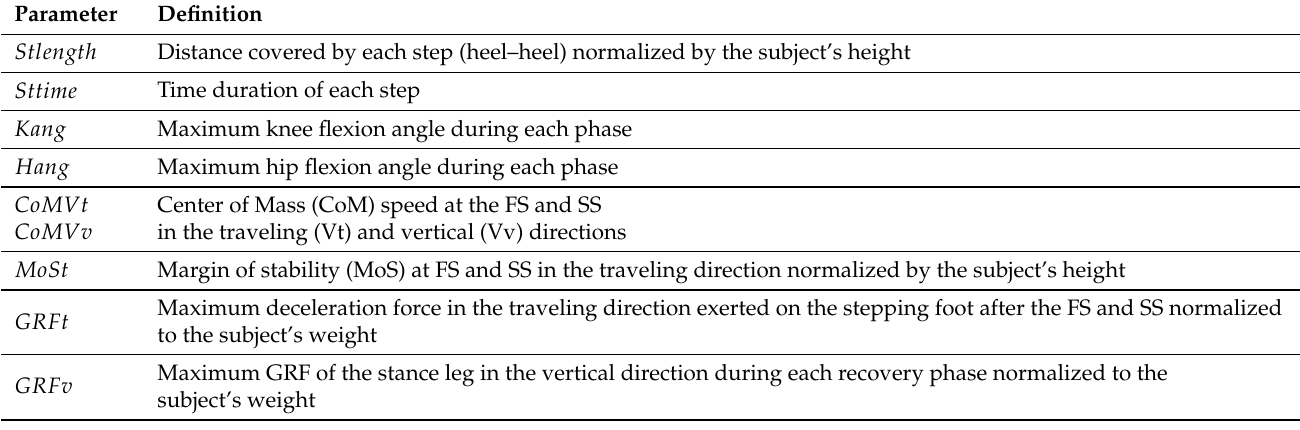
Table 1. Definitions of the recovery motion